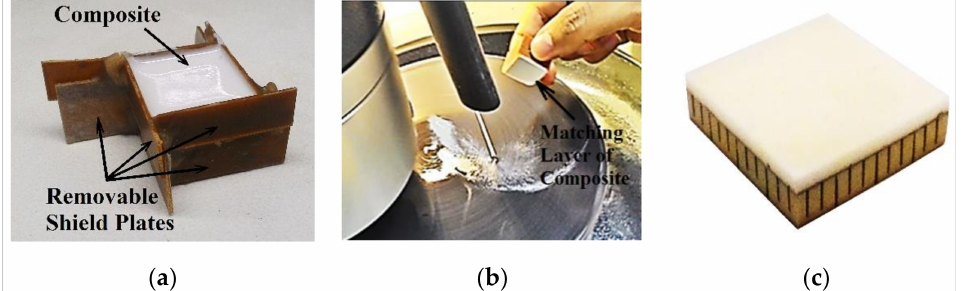
Figure 7. ( a ) The alumina composite was deposited over the ground electrode. ( b ) After it was cured, the composite was manually grinded until reaching the λ /4 thickness. ( c ) Picture showing the accomplished acoustic matching of the 1–3 piezocomposite